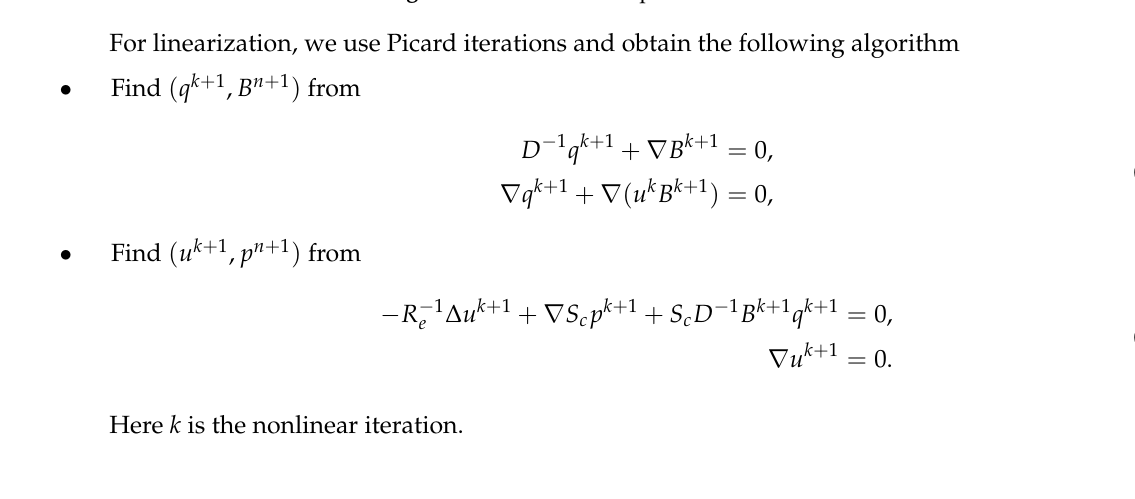
Figure 1. Illustration of a perforated